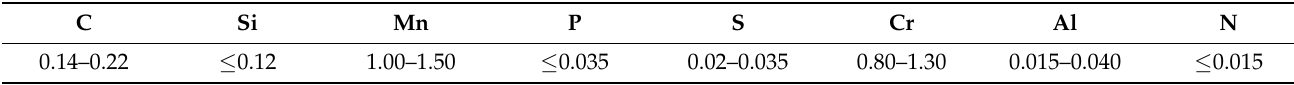
Table 1. Chemical composition of the drilled part given in %.